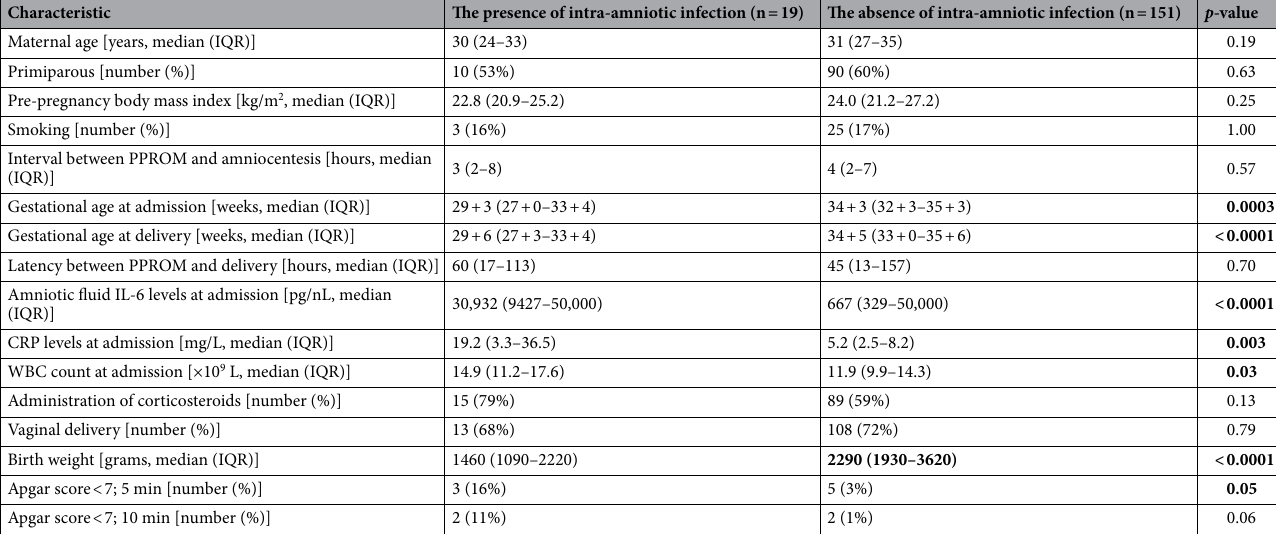
Table 1. Maternal and clinical characteristics of women with preterm prelabor rupture of membranes based on the presence and absence of intra-amniotic infection. Continuous variables were compared using a nonparametric Mann–Whitney U test. Categorical variables were compared using the Fisher’s exact test. Continuous variables are presented as median (IQR) and categorical as number (%). Statistically significant results are marked in bold. CRP: C-reactive protein; IL-6: interleukin-6; IQR: interquartile range; WBC: white blood